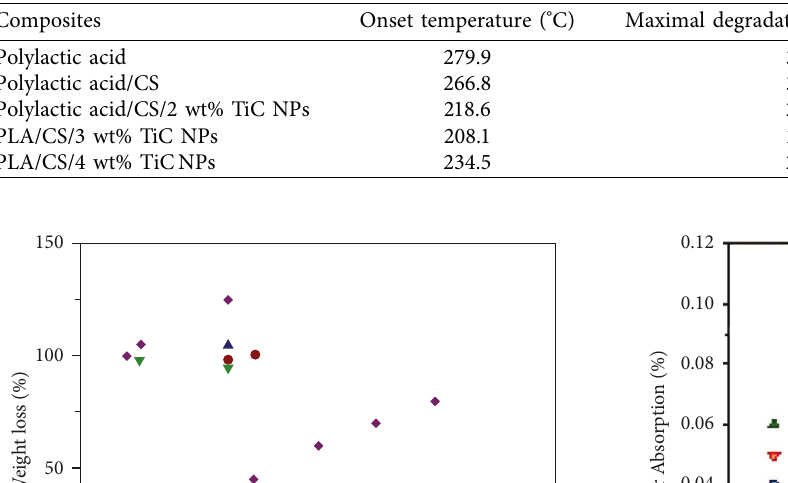
Table 1: Onset temperature, maximal temperature, and % of decomposition of different